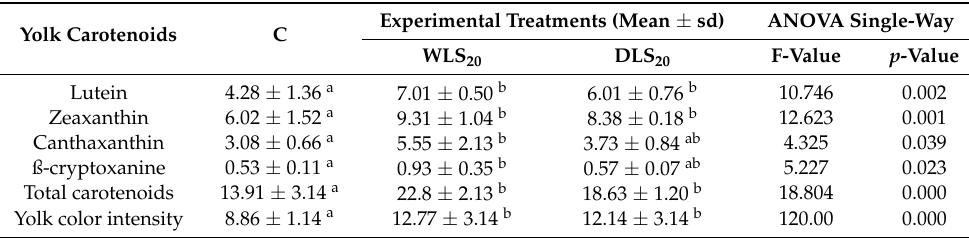
Table 9. Influence of dehulling white lupine seeds on the carotenoids content of egg yolk ( µ g/g fresh